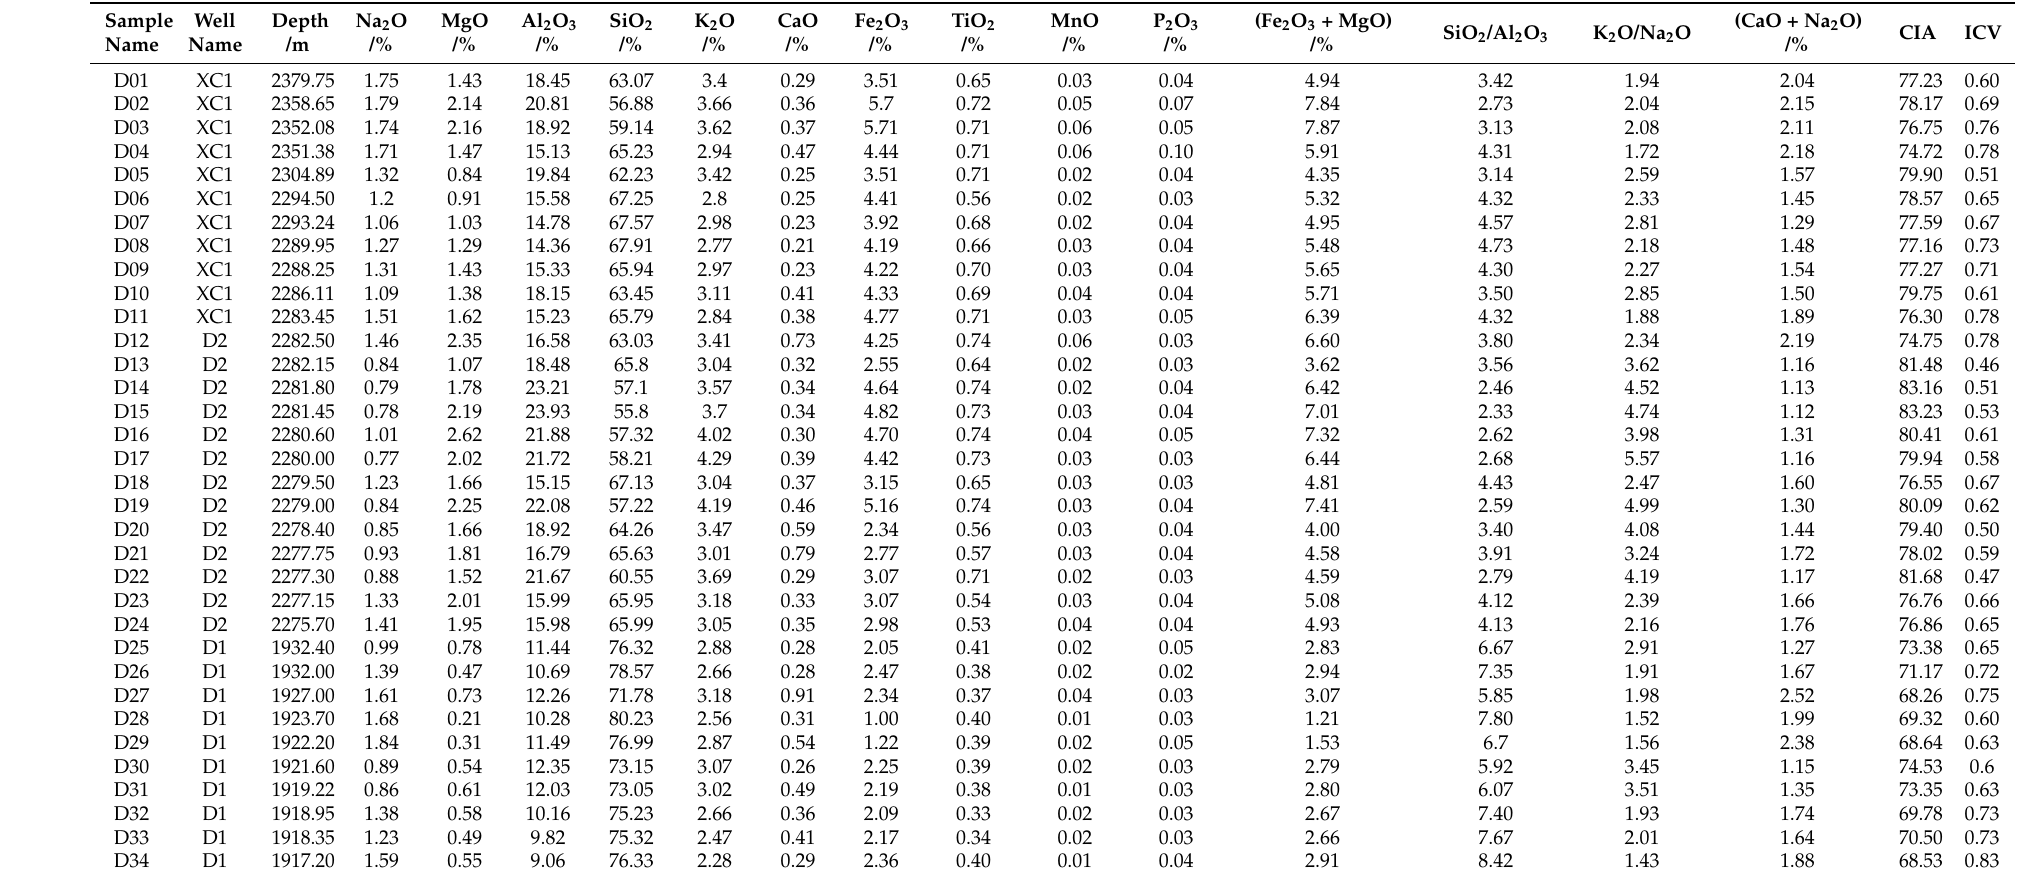
Table 1. Characteristics of major elements of samples from the Zhongjiangou Formation of Wudun